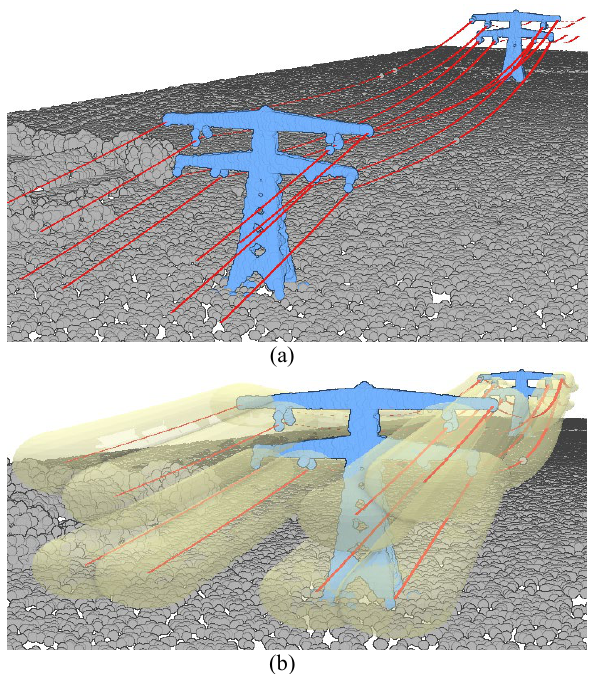
Figure 3. (a) Extracted power lines from point cloud, and (b) the generation of buffer